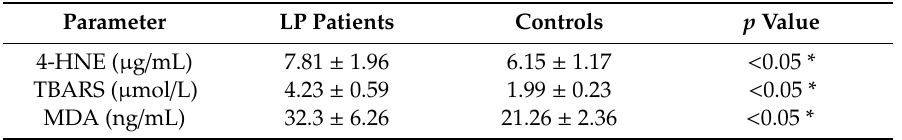
Table 3. The levels of pro-oxidant markers in lichen planus (LP) patients versus controls (expressed as mean and standard deviation).